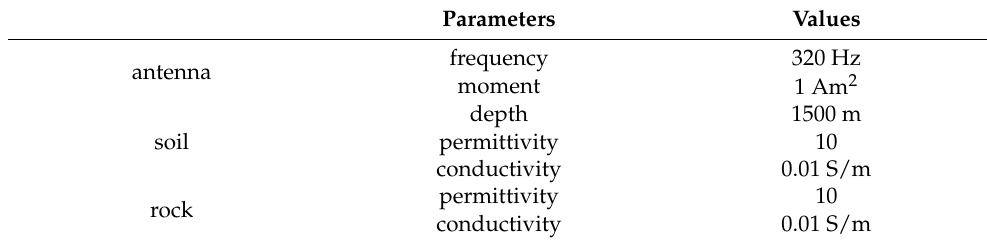
Table 2. The parameters of the simulation.